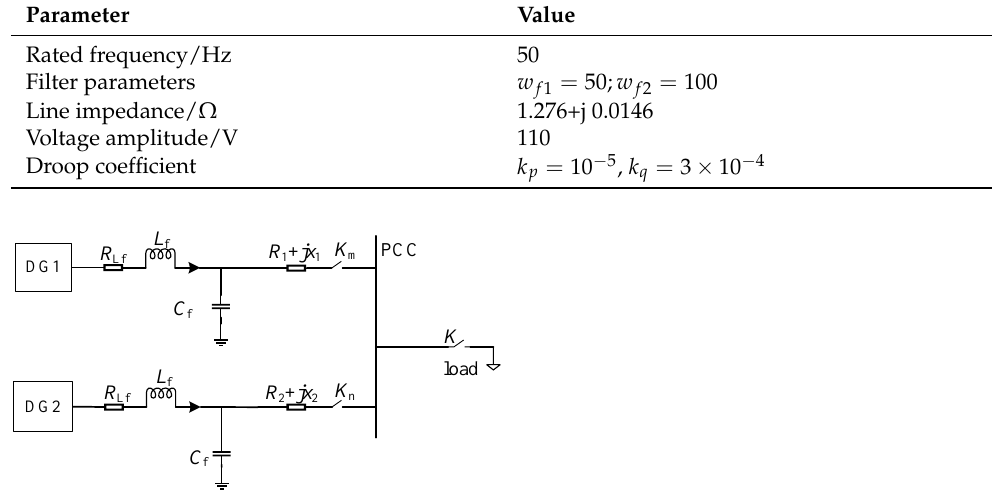
Figure 10. Microgrid simulation model.